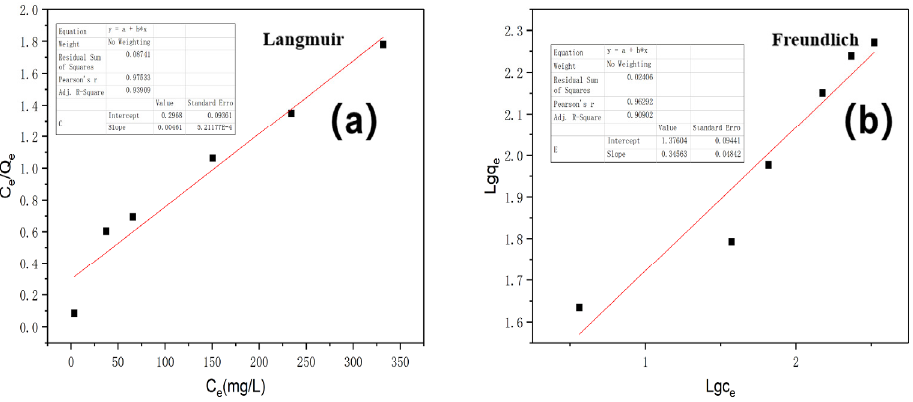
Figure 10. The Cr(VI) adsorption isotherm fitted by ( a ) Langmuir and ( b ) Freundlich models. Figure 9. The adsorption isotherm ( a ) of Fe/CA and the comparison of Cr (VI) adsorption capacities for different adsorbents ( b ).